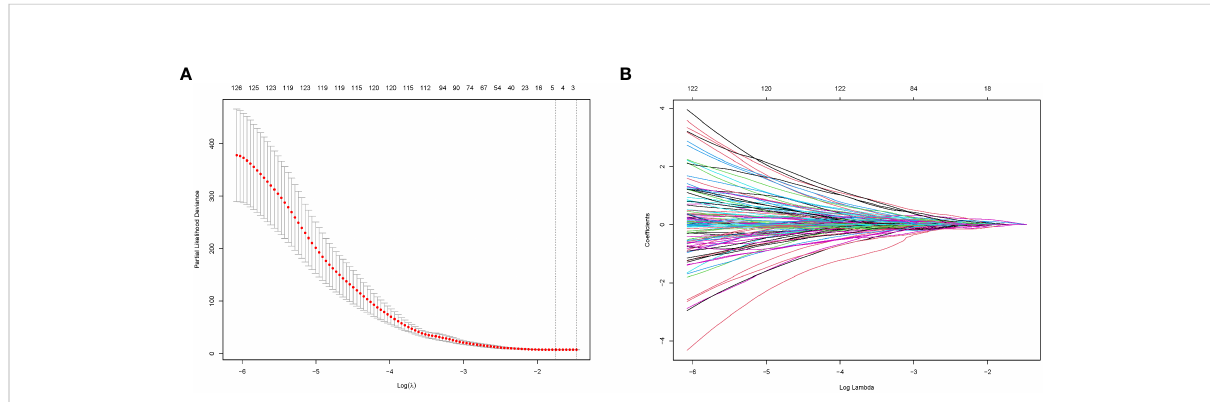
FIGURE 3 Radiomics feature selection by LASSO regression. (A) Selection of tuning parameters (lambda value) in the LASSO model using ten-fold cross- validation by the minimum criteria. (B) LASSO coef fi cient pro fi les of the radiomics features.